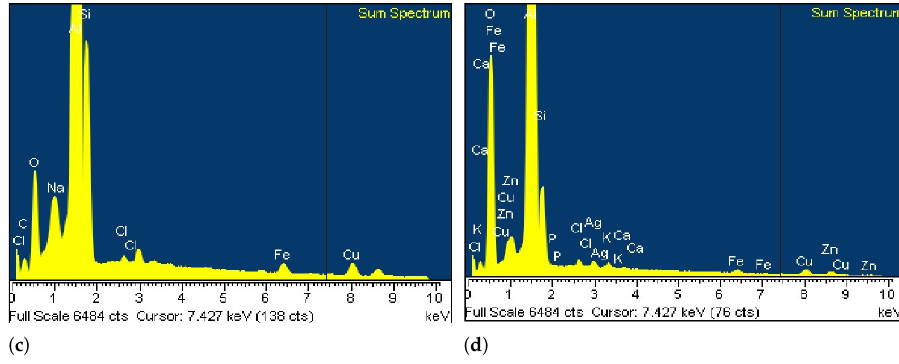
Figure 7. SEM analysis: ( a ) batch 3 Part 3; and ( b ) batch 4 Part 4; ( c ) composition of failure area; and ( d ) composition in